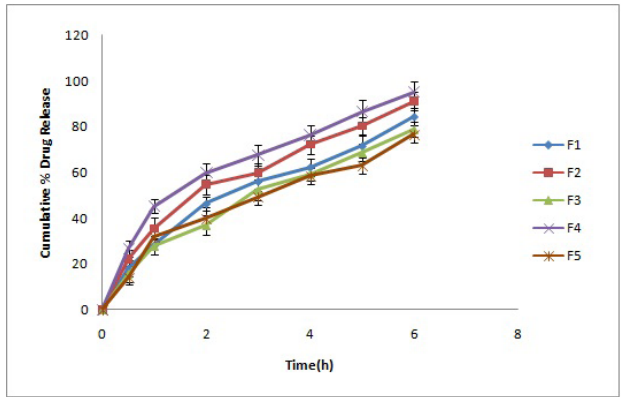
FIGURE 3 - I n-vitro release profile of hydralazine hydrochloride muco-adhesive buccaltablets.